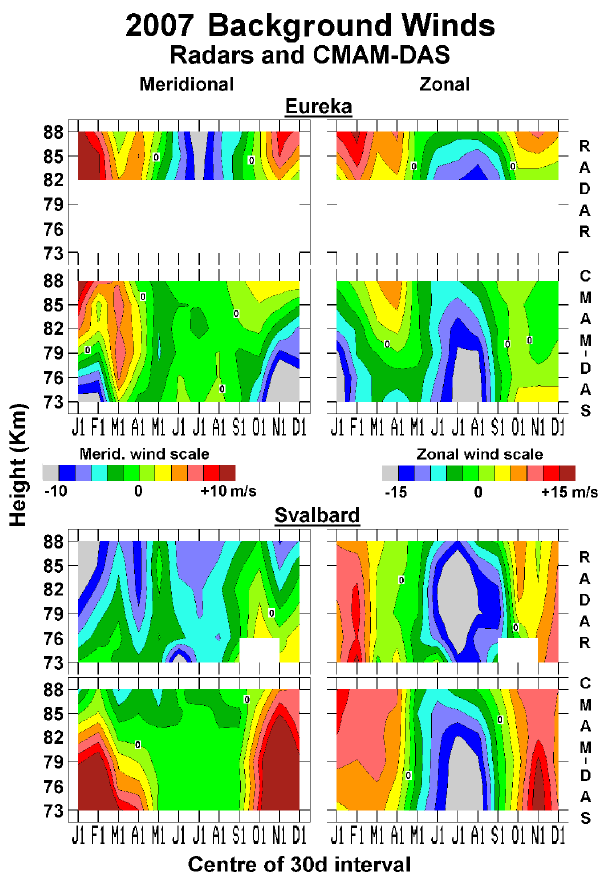
Fig. 5. Background winds for 2007 from the Eureka and Svalbard MWR and CMAM-DAS (see text for more details): these are from thirty-day fits for the mean winds and 12- and 24-h tidal oscillations. The fits have the first day of each month as their mid-point, and contours result from a bilinear interpolation